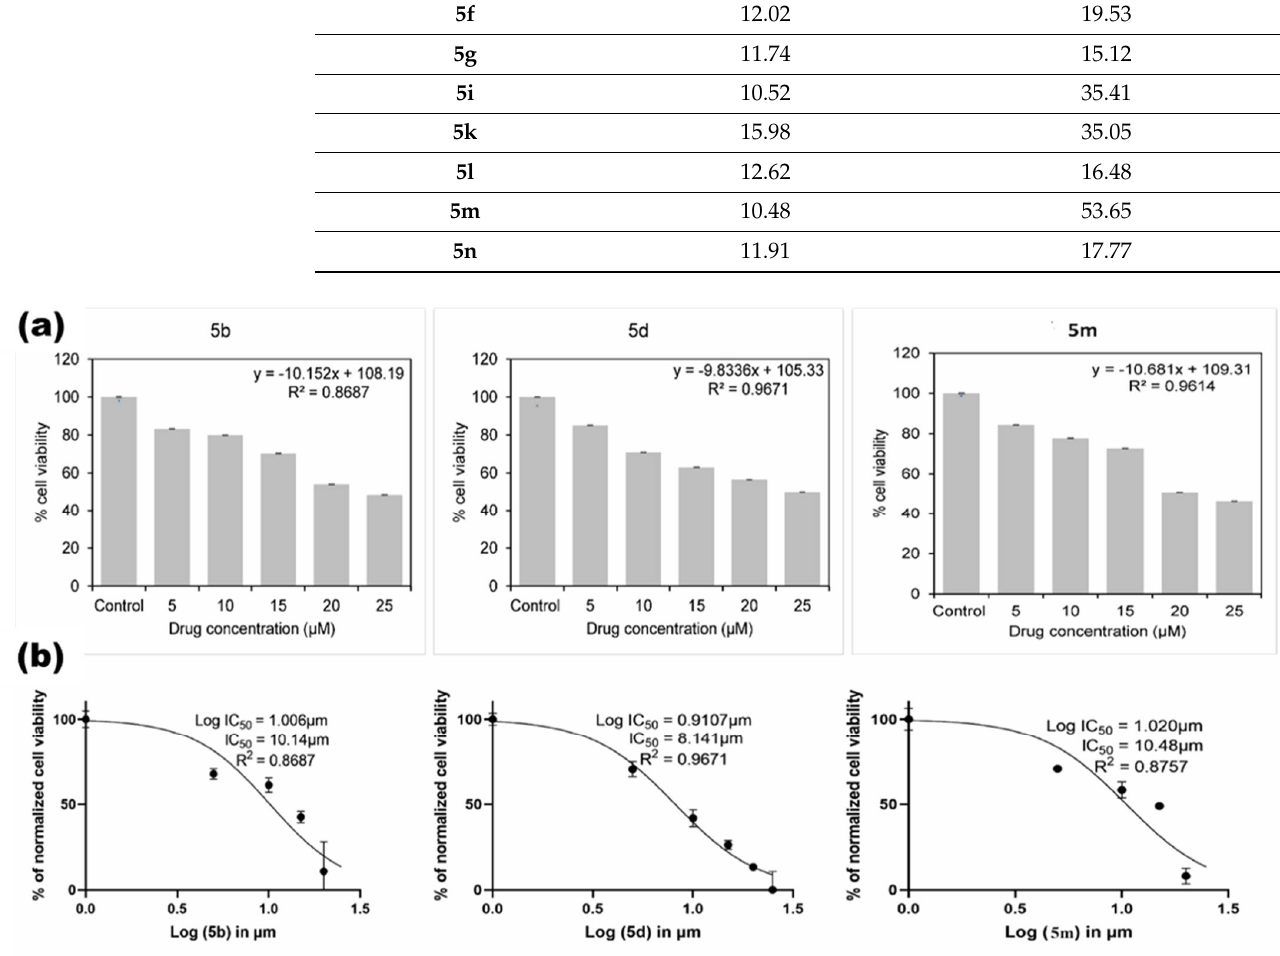
Figure 7. ( a ) % Cell viability and ( b ) hill plot curve representing the IC 50 for the screened oxadiazole derivatives.